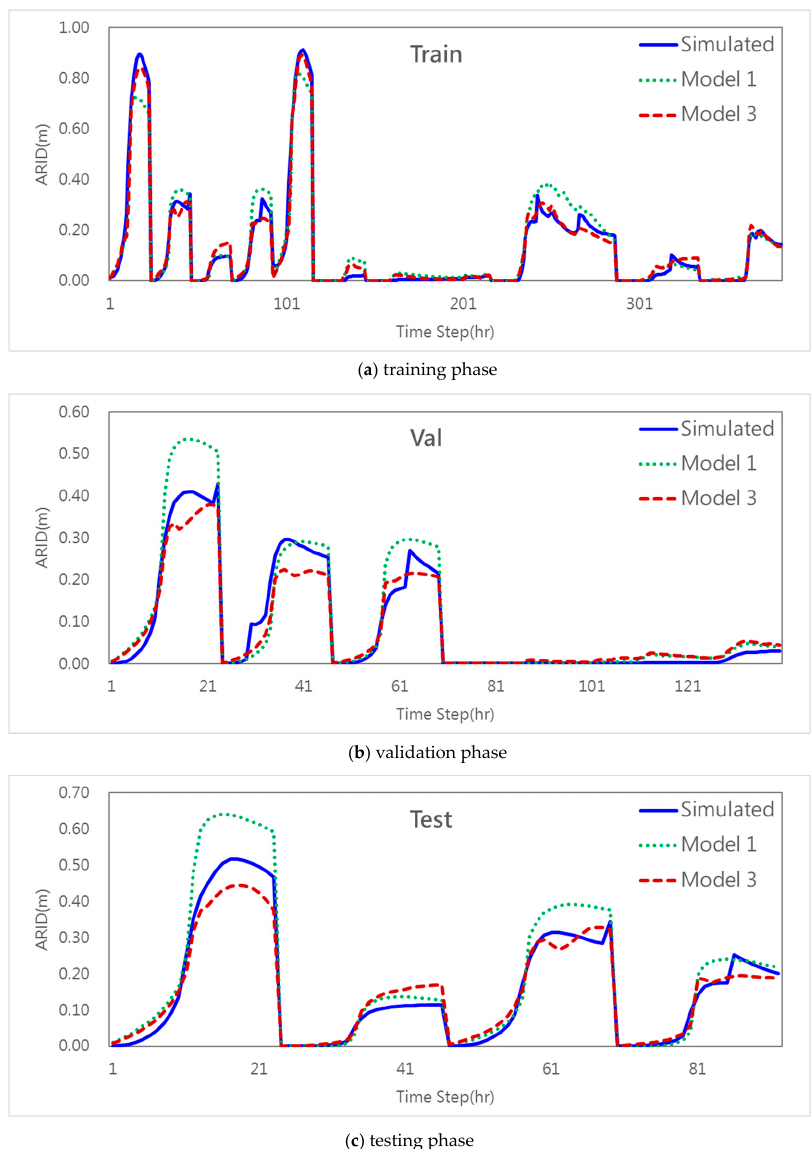
Figure 8. Comparison of simulation, Model 1, and Model 3 in three phases. ( a ) training phase; ( b )validation phase; ( c )testing